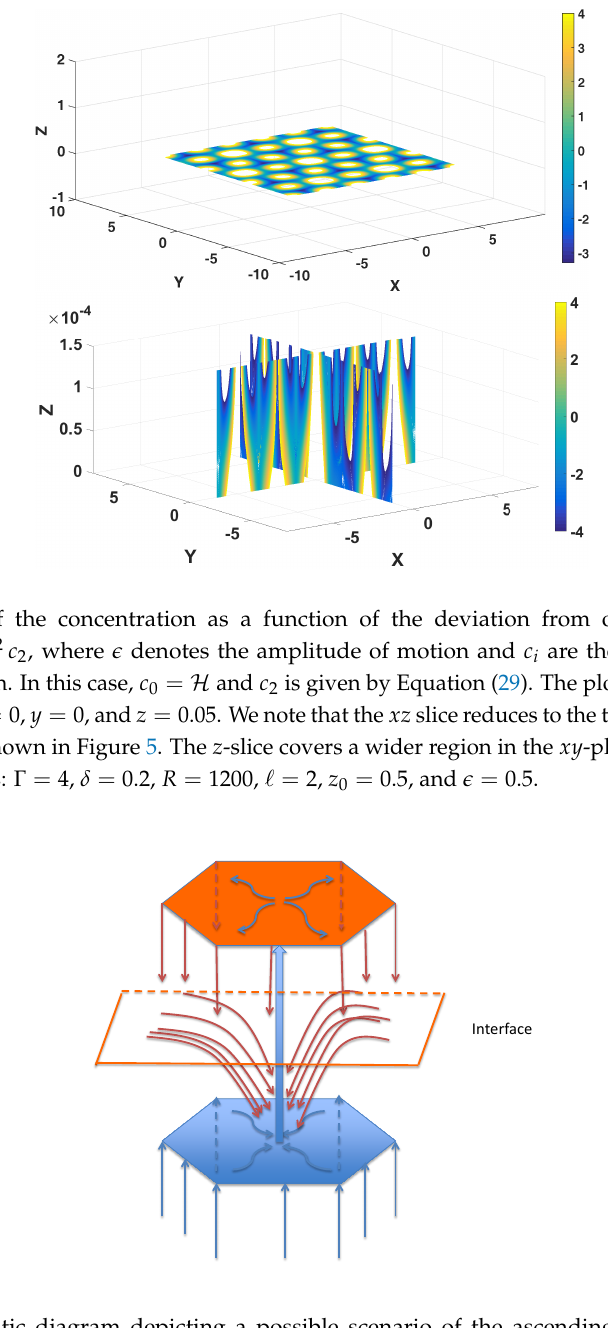
Figure 7. Schematic diagram depicting a possible scenario of the ascending light currents and descending carbon-rich currents near the interface at z = z 0